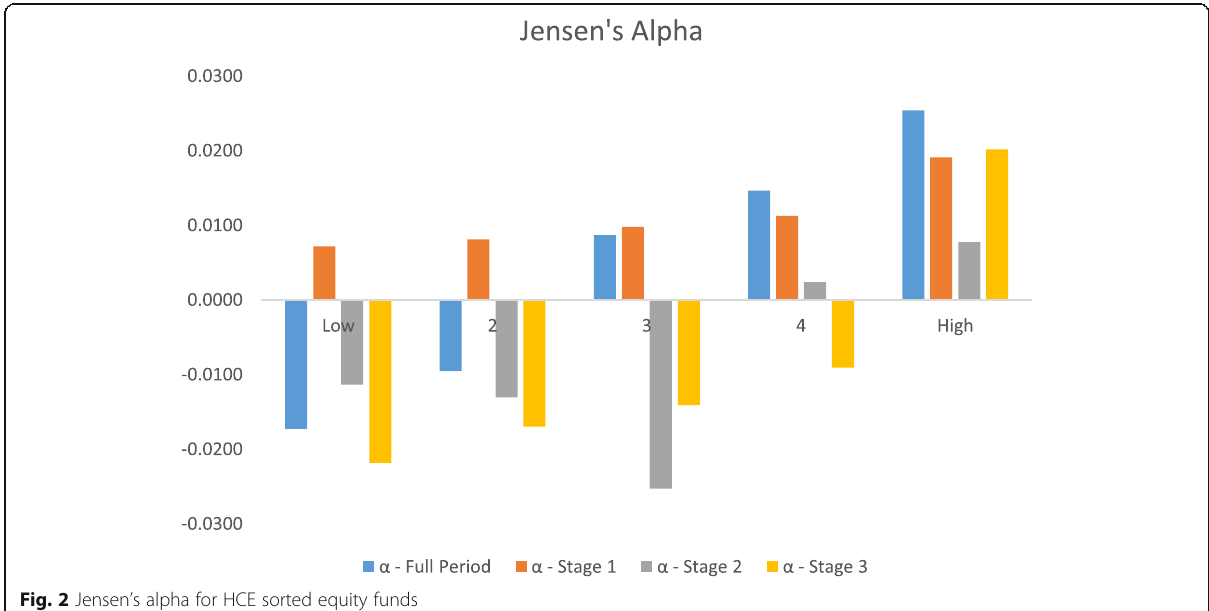
Fig. 2 Jensen ’ s alpha for HCE sorted equity funds